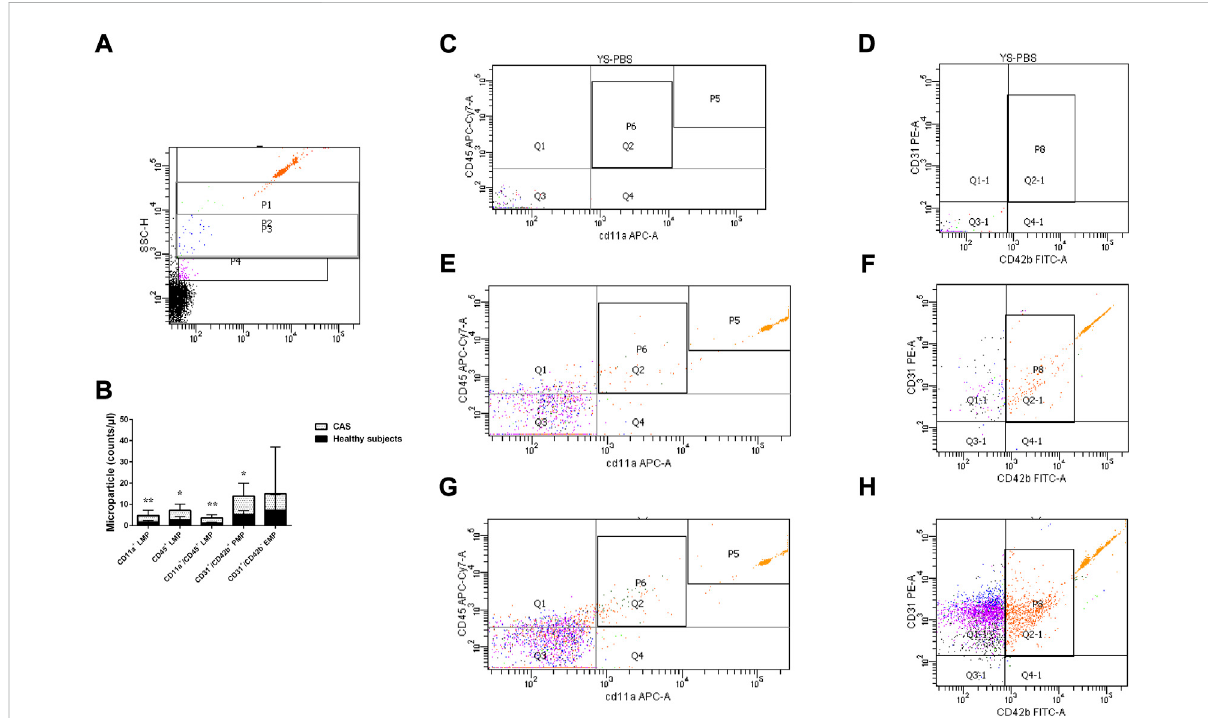
FIGURE 2 (A) P1-P3representgatessetwithbeadstandards1,0.5,and0.24 μ m,respectively. (B) .ThequantitativeexpressionofLMP,PMP,andEMPinthe twogroups. (C,D) standforthenegativecontrol. (E,F) standforthehealthysubjectsgroup,and (G,H) standfortheCASgroup;P6representsCD11a + / CD45 + LMP,Q1&P6representsCD45 + LMP,Q4&P6representsCD11a + LMP,P8representsCD31 + /CD42b + PMPandQ1-1representsCD31 + /CD42b − EMP. P5 represents the quantity of micro bead standard. Values are shown as median [25th – 75th percentile]. * p < 0.05, ** p < 0.01 vs. healthy